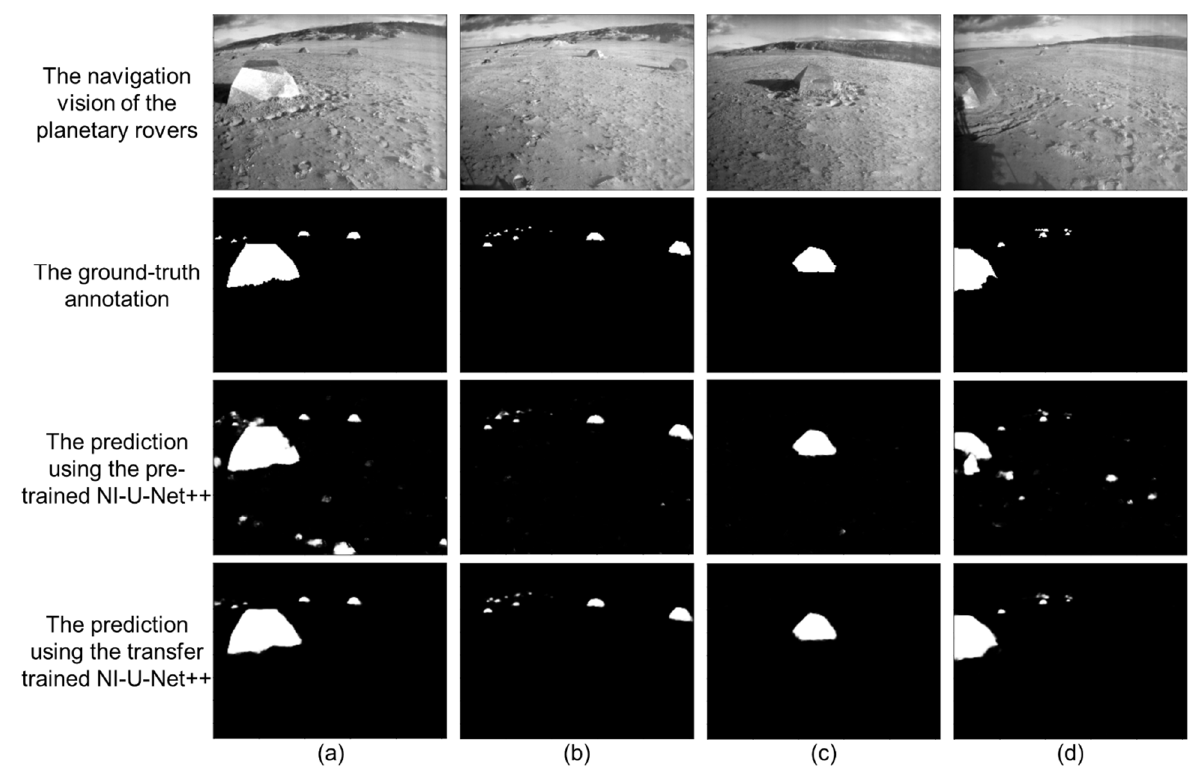
Figure 11. The visualized results of the proposed NI-U-Net++ in the transfer-training process. The navigation vision of the planetary rovers refers to the images from the Katwijk dataset. ( a – d ) refer to four variant selected images.